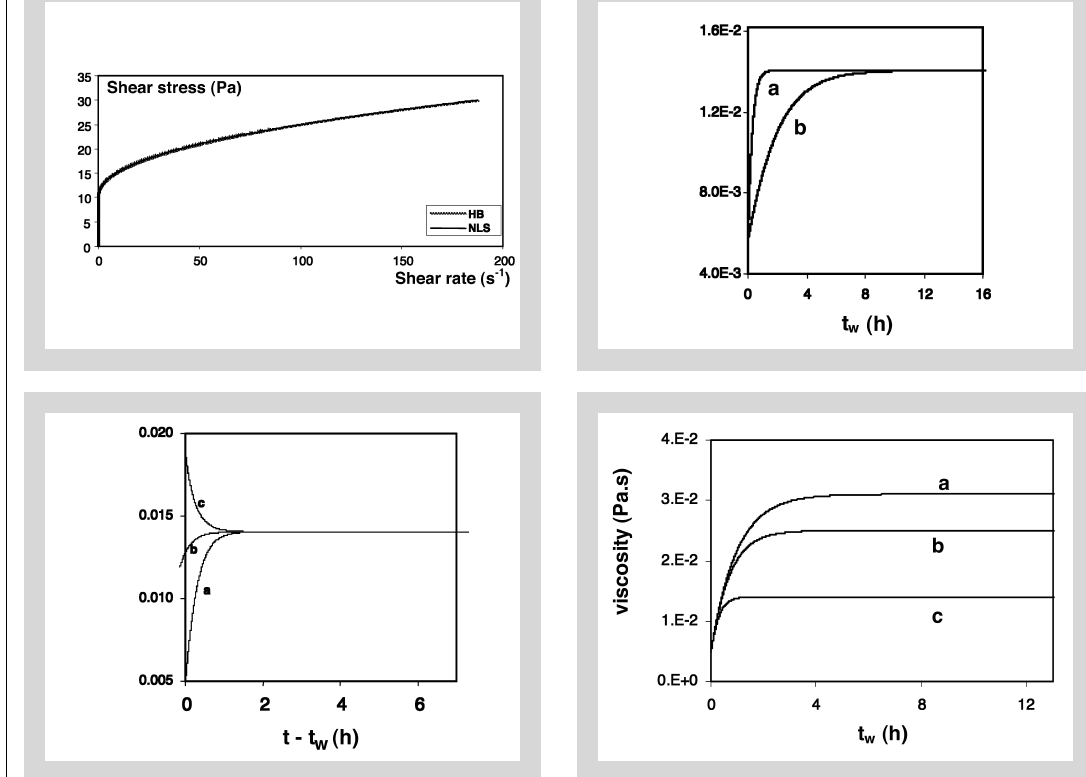
Figure 10 (left above): Fitting HB-model to NLS- model curves (NLS parame- ters: h = 10 mPa, • s = 50 Pa, s = 10 Pa, c B HB parameters: